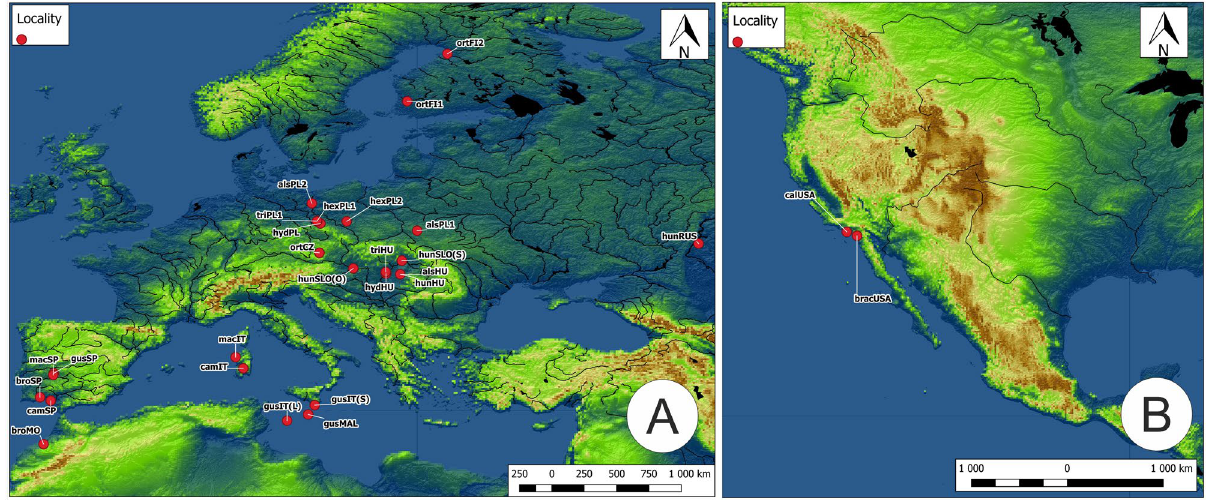
Figure 1. Location of the tested seed populations of Elatine ; ( A ) Europe and Africa, ( B ) North America; explanation of abbreviations in Table